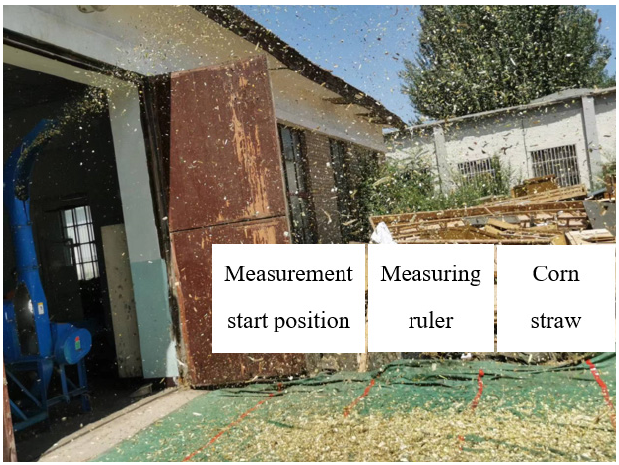
Figure 7. Test site. Figure 7. Test